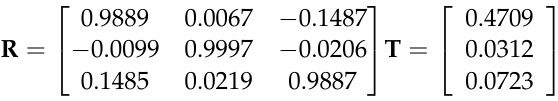
Figure 15. Adaptive optimal neighborhood radius distribution of point cloud. ( a ) Adaptive optimal neighborhood radius distribution of template point cloud. ( b ) Adaptive optimal neighborhood radius distribution of ground scene point cloud.